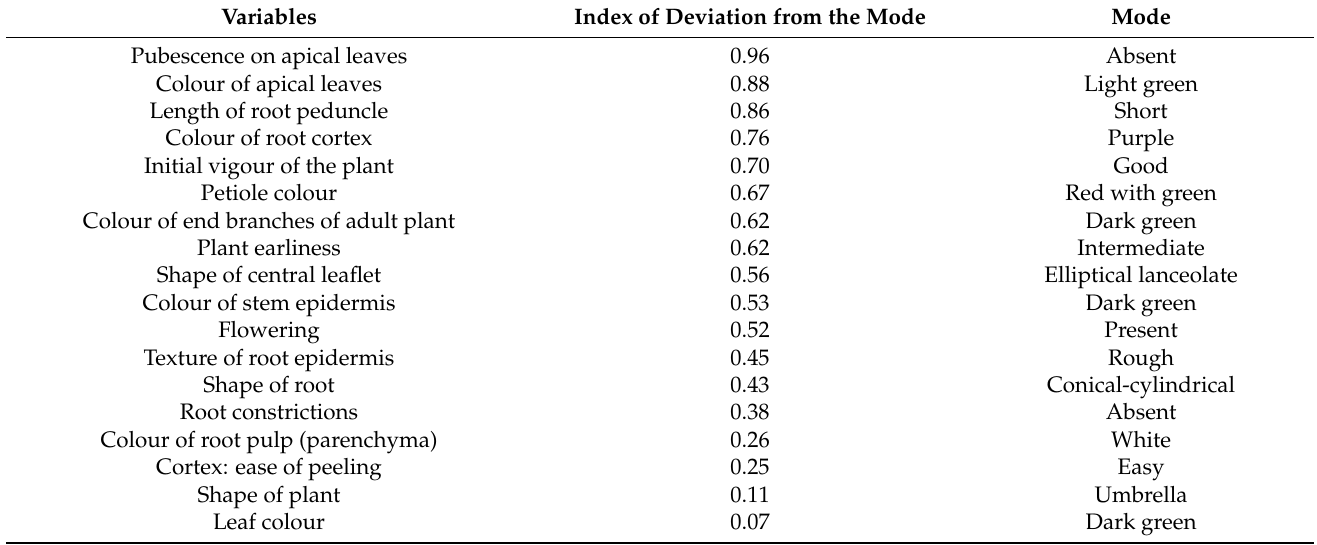
Table 2. Morphological variability in qualitative characters in the cassava collection from the Ecuadorian regions. The different character states recorded for each character are given in Table